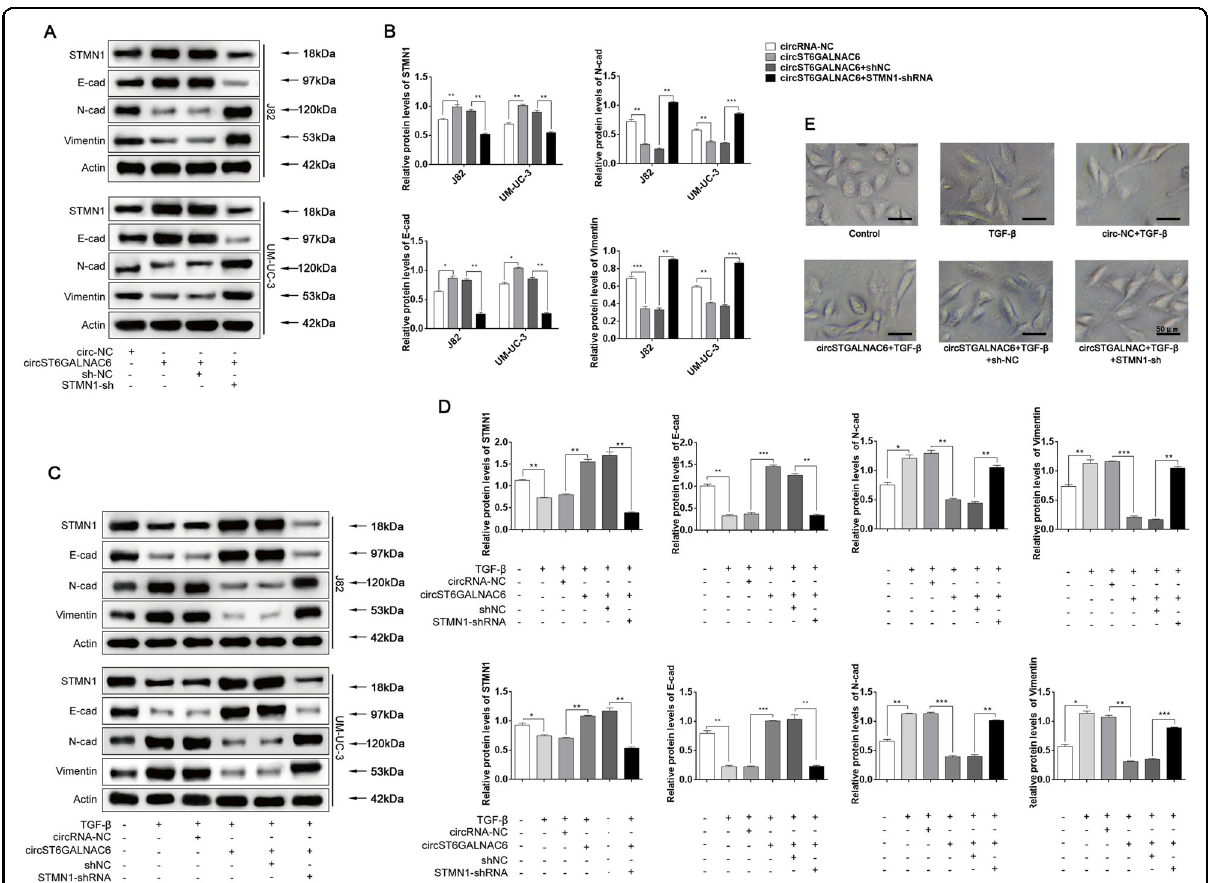
Fig. 6 circST6GALNAC6 regulated EMT via miR-200a-3p/STMN1 signalling. A , B Relative protein levels of STMN1 and EMT-related proteins in transfected cells were detected by western blotting. C , D Relative protein levels of STMN1 and EMT-related proteins in transfected cells following TGF- β 1 treatment. E UM-UC-3 cells were transfected with circST6GALNAC6 or circRNA-NC or circST6GALNAC6 plus STMN1-shRNA or shNC, and then treated with 50 ng/ml TGF- β 1 for 72 day. And then, the cell morphology of UM-UC-3 was observed. *** P < 0.001, ** P < 0.01 and * P <